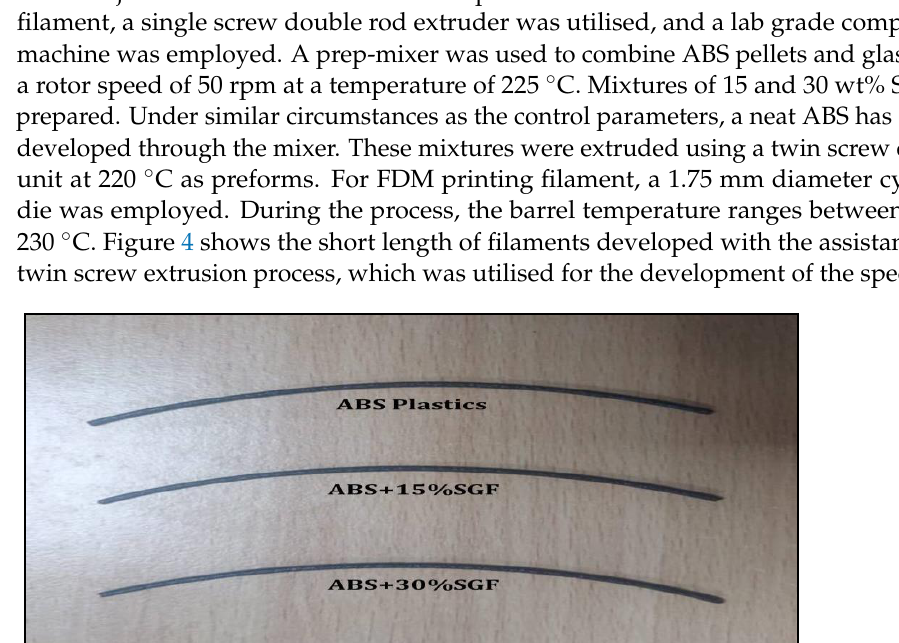
Figure 3. SEM and EDAX of as received short glass fibre.